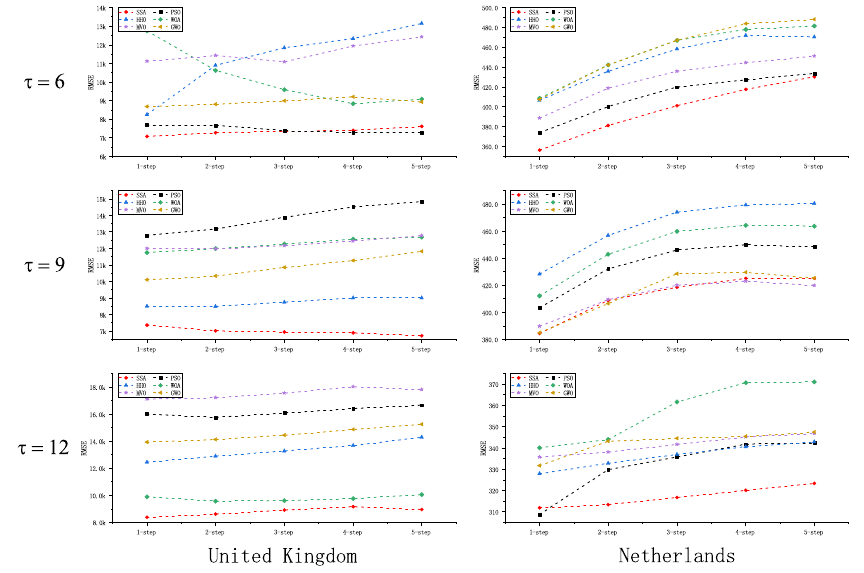
Figure 19. RMSEs of models on different datasets.